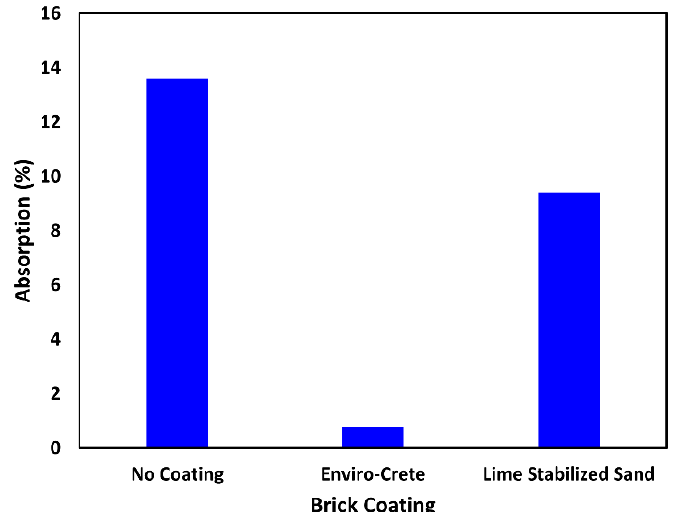
Figure 3. Water absorption tests of uncoated and coated bricks.